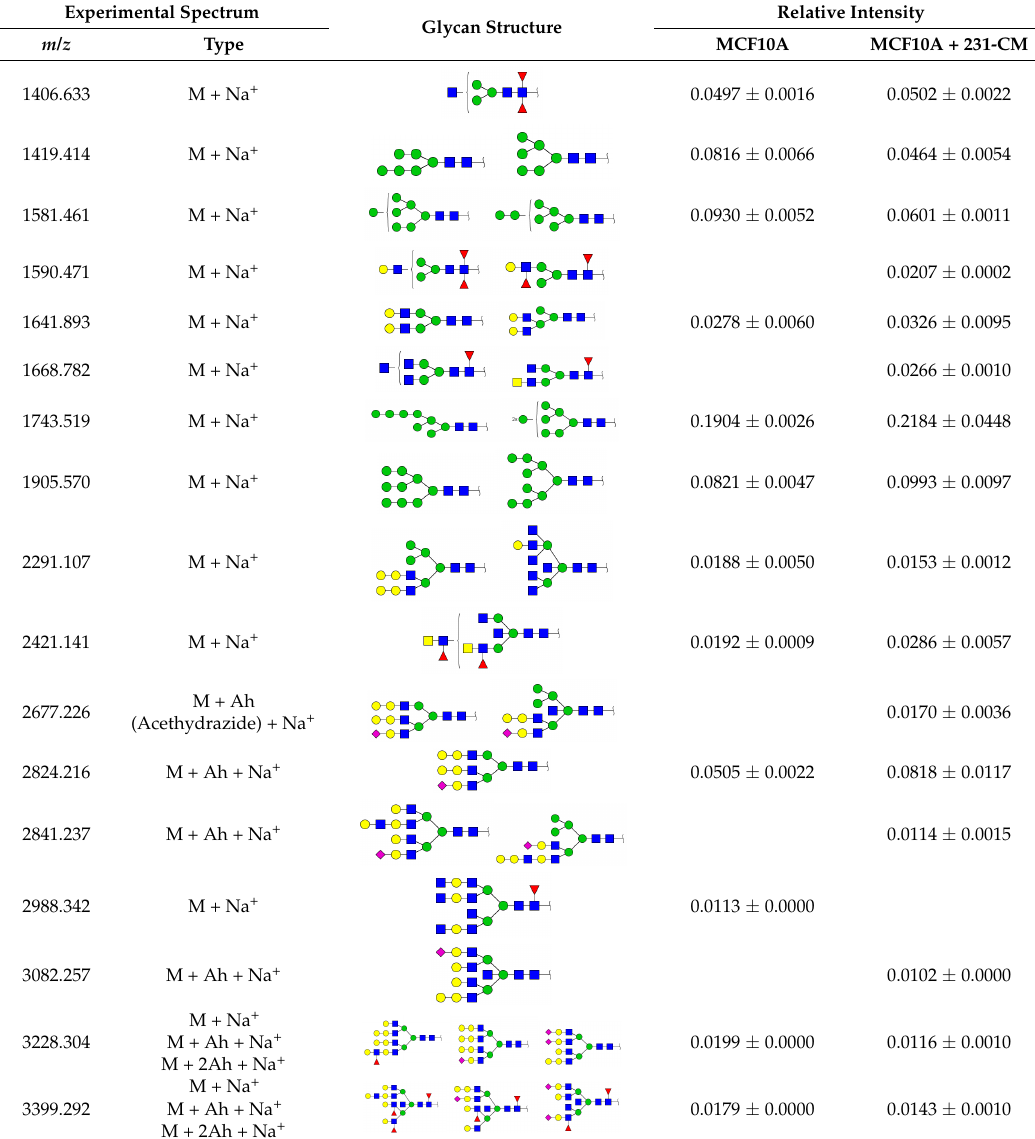
Table 1. Proposed structures and their molecular ions in MALDI-TOF/TOF-MS spectra of N -glycans from the control and 231-CM-treated MCF10A cells.